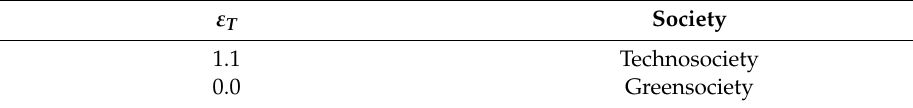
Table A1. Society and safety factor for levee